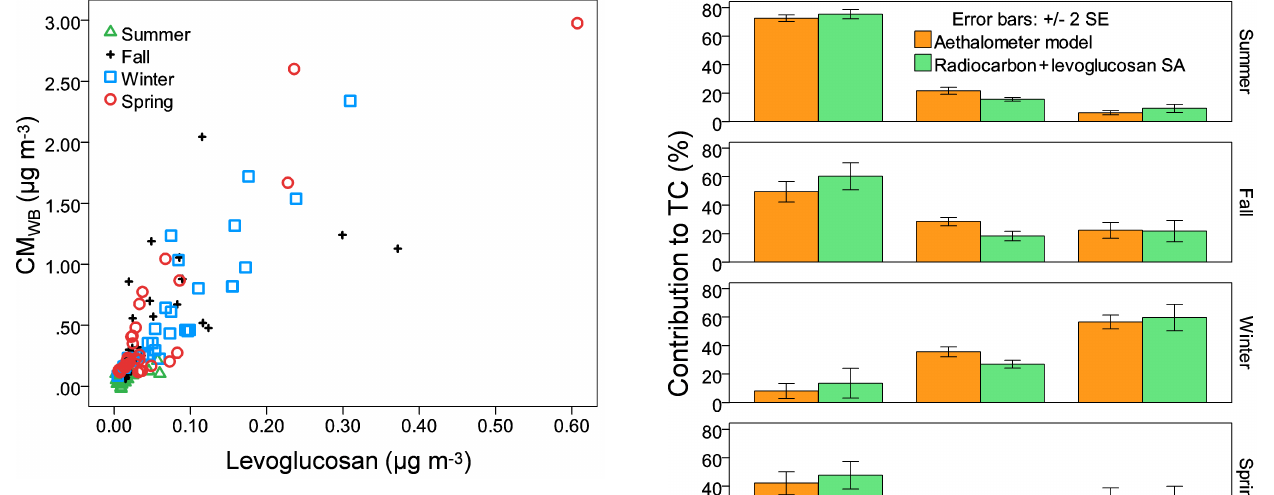
Figure 5. Comparison between CM WB and levoglucosan. R 2 = 0 . 70, N = 122.